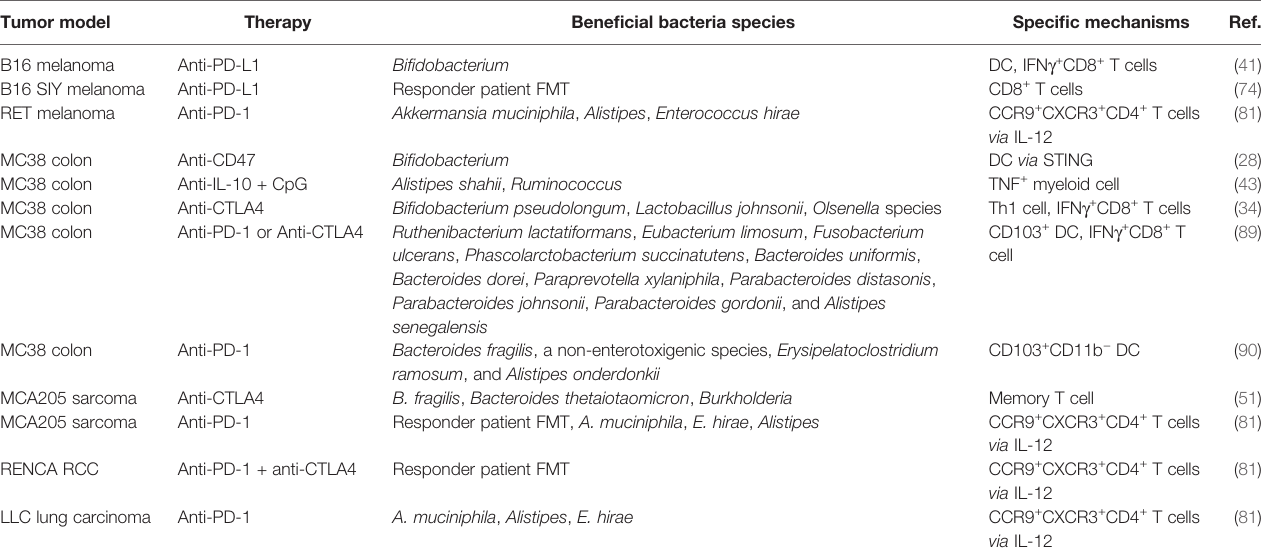
TABLE 2 | Gut microbiota enhancing cancer immunotherapy in